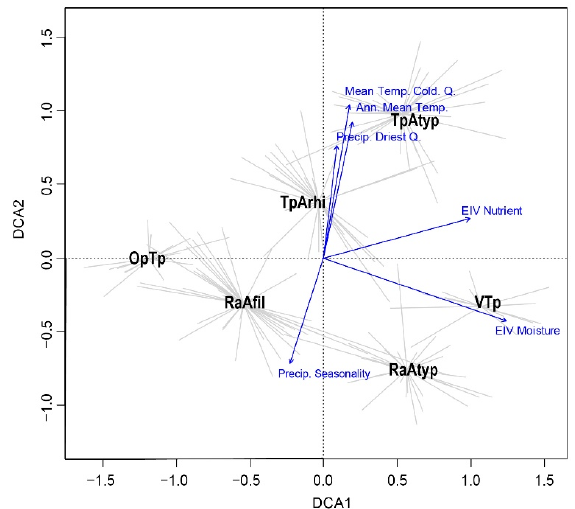
Figure 4. Diagram of Detrended Correspondence Analysis (DCA) of relevés with the centroid of groups and spider plots with passively projected EIV nutrient and EIV moisture and climatic variables—precipitation seasonality, mean temperature of the coldest quarter, mean annual temperature, precipitation in the driest quarter. Eigenvalues for the first two axes are 0.493 and 0.295, respectively. The legend is the same as in Figure 3.